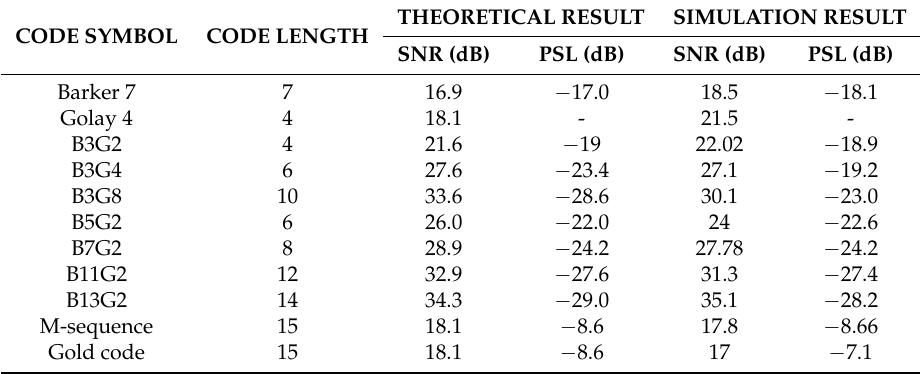
Table 3. Signal–noise ratio (SNR) and peak sidelobe level (PSL)